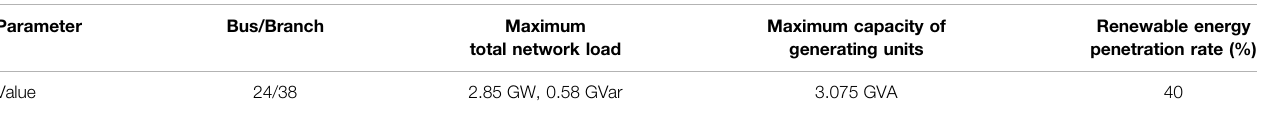
TABLE 1 | IEEE 24-bus based network parameters.